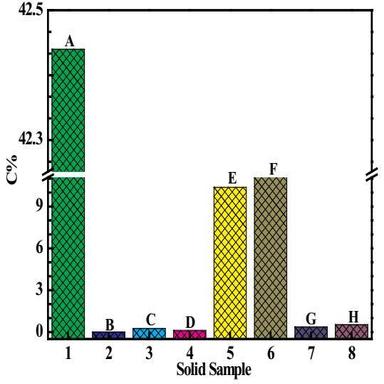
Elemental analysis of carbon of solid samples.